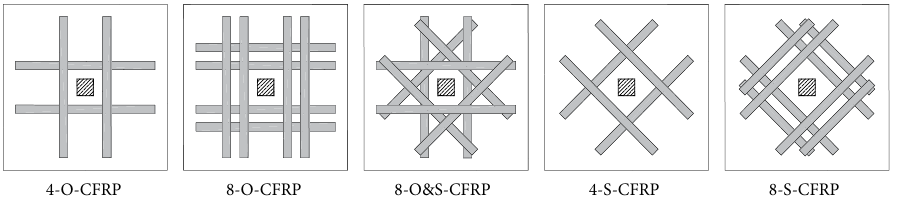
Figure 5. The arrangement of the composite strips considered in the study by Sharaf et al. (2006) Table 3. The characteristics of the models considered in the research by Sharaf et al. (2006)